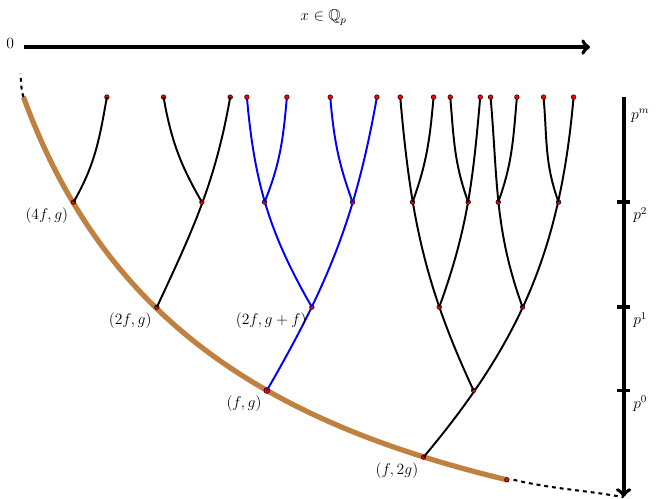
Figure 17. Bruhat-Tits tree for p = 2. Here f (cid:17) ~f 0 and g (cid:17) ~g 0